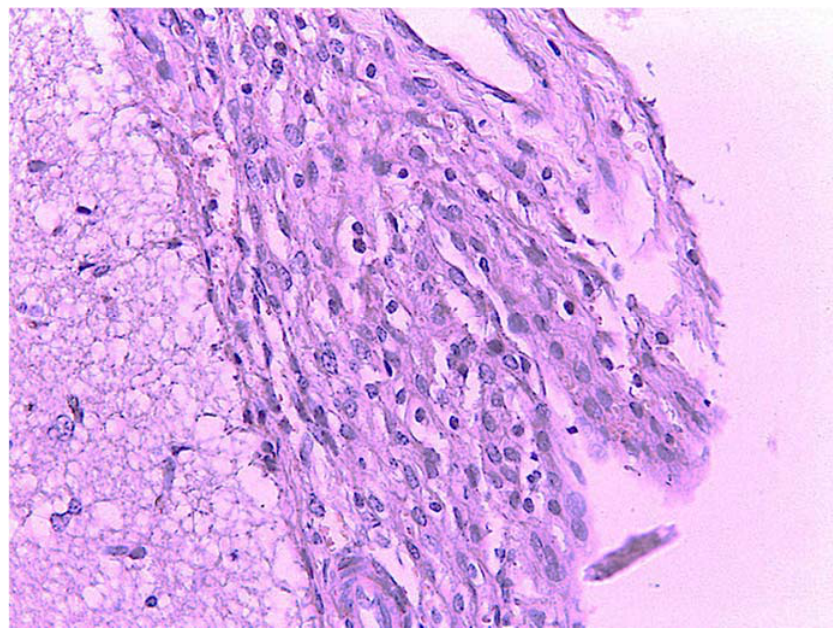
Figure 6. Leptomeninges: macrophage–lymphocytic infiltrate. H.E. Magnification: 40 × .